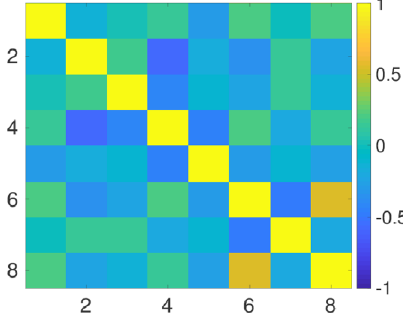
Fig. 4. Correlation matrix from